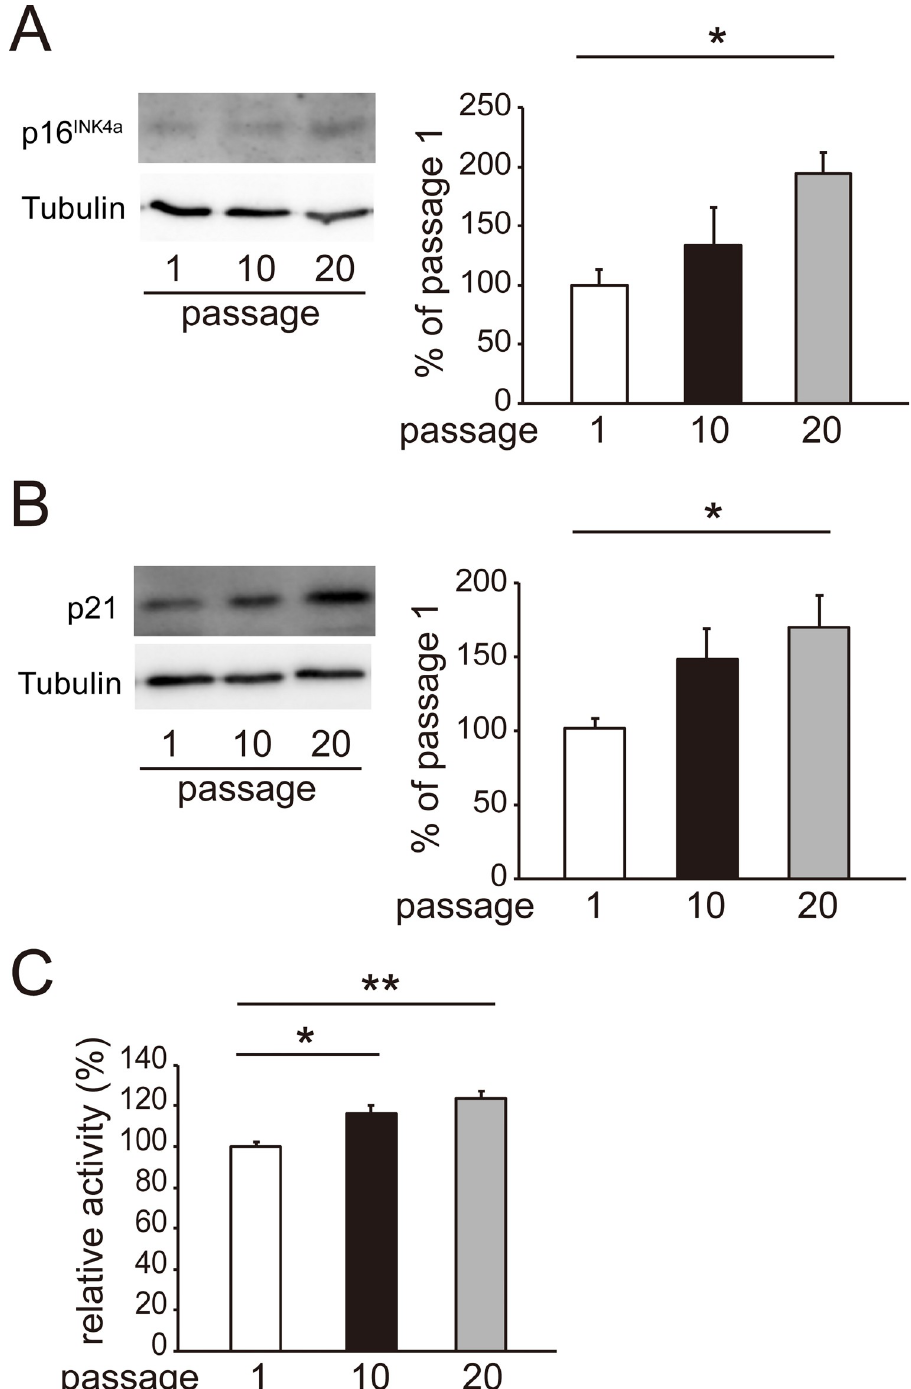
Fig 1. Induction of replicative senescence by high passage number in C2C12 cells. Panels A and B show representative western blots of p16 INK4a and p21 as senescence markers and tubulin as an internal control, respectively. Cells were subjected to passage once (passage 1), 10 times (passage 10), or 20 times (passage 20). The band density of p16 INK4a or p21 was normalized with that of tubulin. The normalized density was compared with the average of the normalized density in passage 1. Data are presented as means ± SE (n = 4 dishes). � P < 0.05 (Dunnett 0 s test). Panel C shows the relative β -galactosidase activity. Data are presented as means ± SE (n = 6 wells). � P < 0.05, �� P < 0.01 (Tukey–Kramer